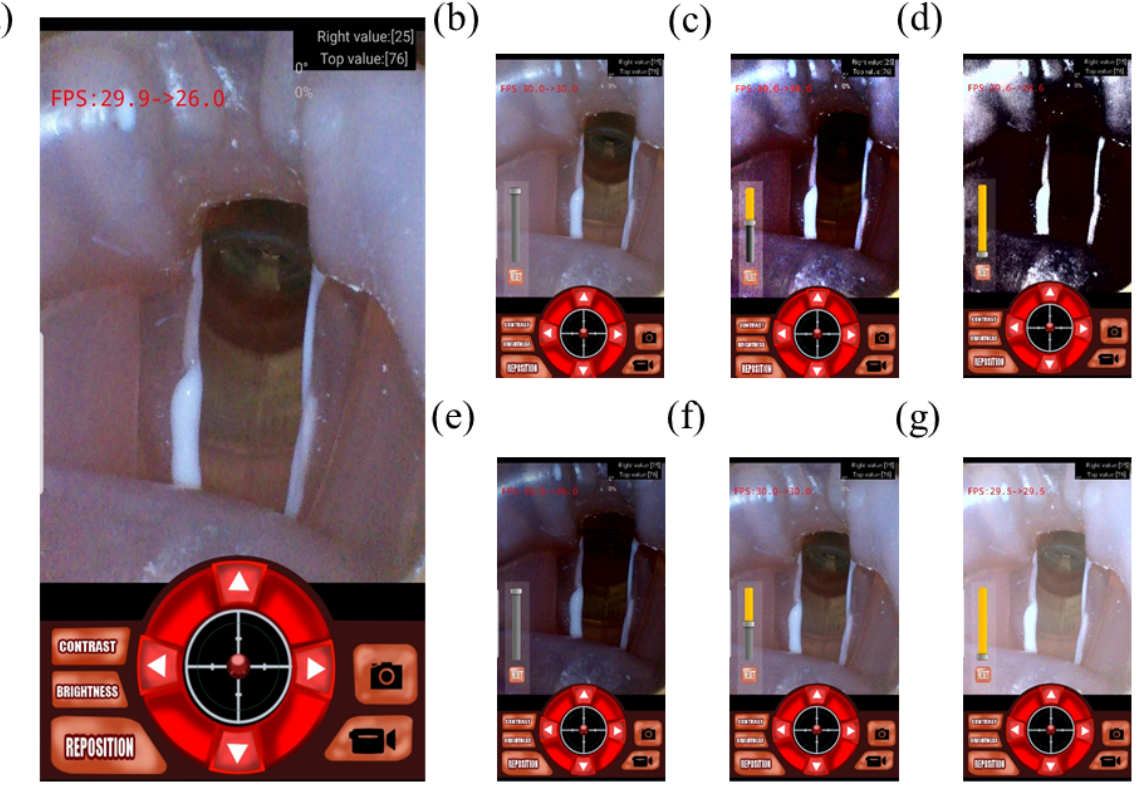
Figure 8. Software-controlling user interface (UI) of the homebuilt smartphone app: (a) main UI of the app (joystick and motor control buttons are in the center, contrast and brightness adjustment buttons are on the left, and movie and still-image capture buttons are on the right), (b-d) slider UI for contrast adjustment and corresponding processed images, and (e-g) slider UI for brightness adjustment and corresponding processed